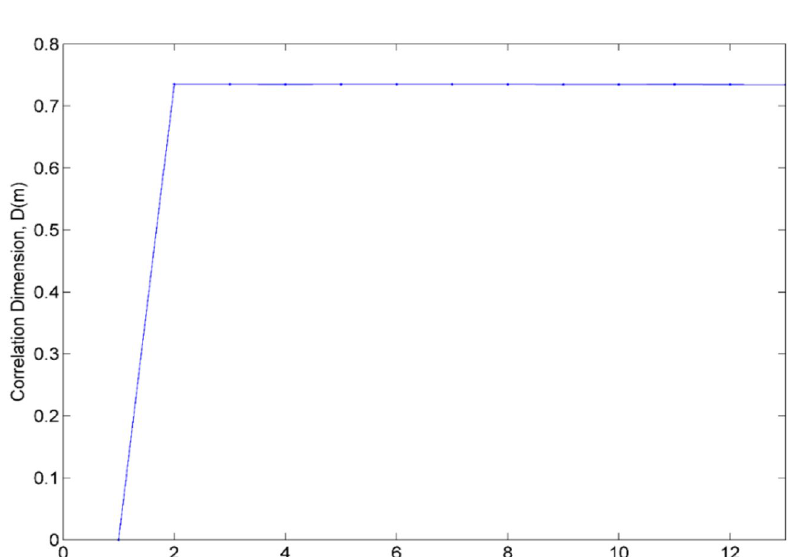
Fig. 5 D ( m ) versus m plot of planetary K -index